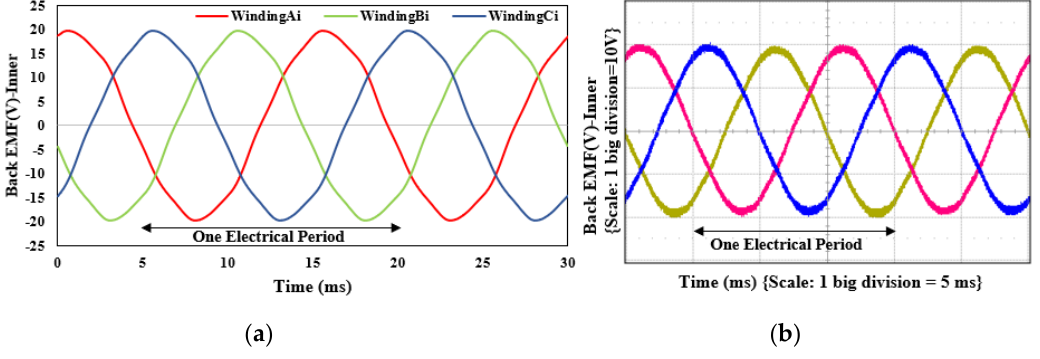
The RMS value of the back EMF of the outer stator obtained from 2D FEM was 14.9 V, which was similar to the value obtained from the prototype experiment, i.e., 14.7 V.